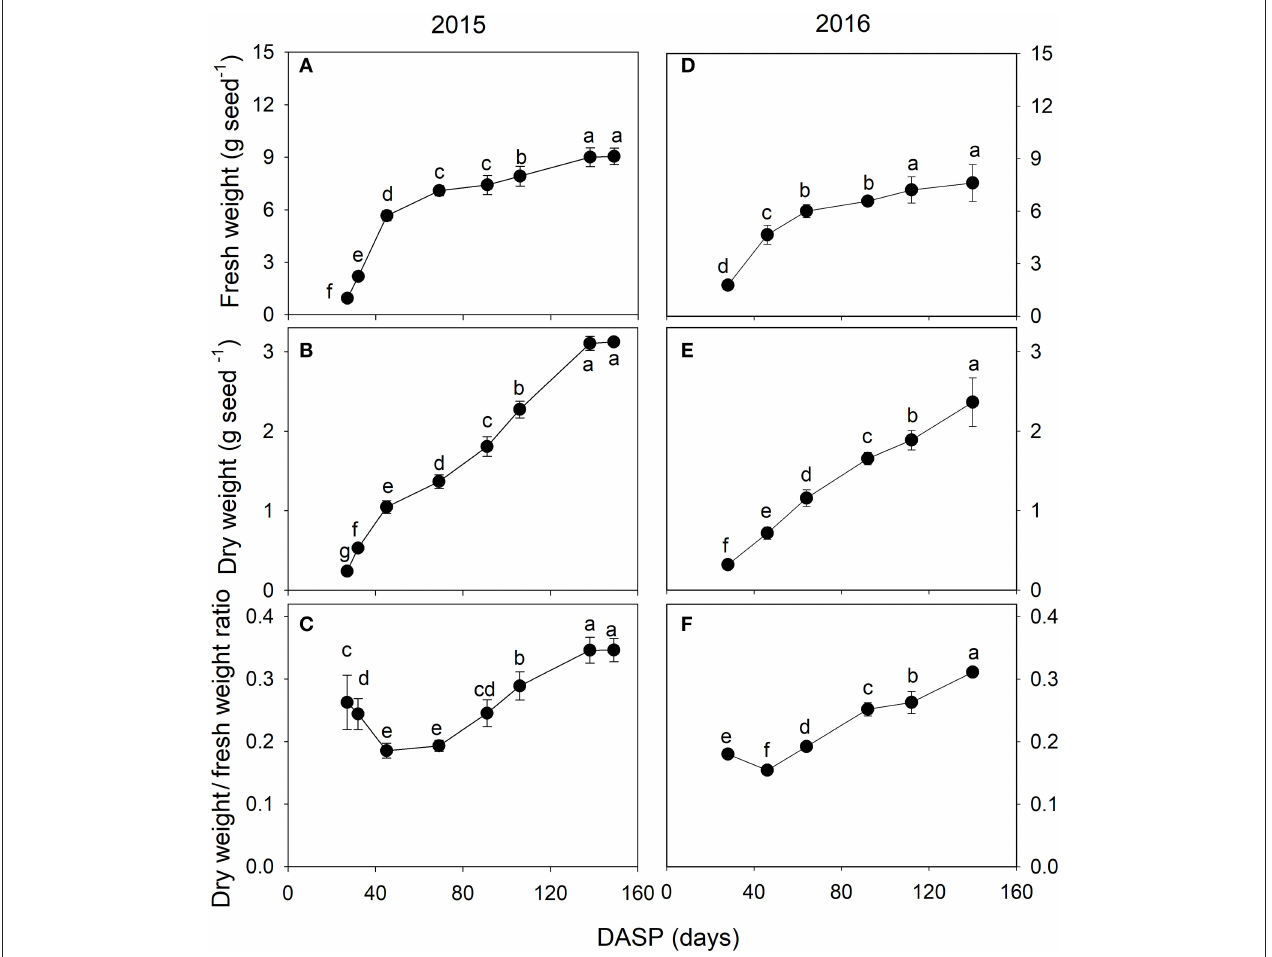
( Figure 8B ): In the seeds, the rate of gross photosynthesis P g was very high at the beginning of the seed development. After that it decreased rapidly. In the leaves, a contrasting pattern from low rates of P g at the beginning of the growing season to higher ones later was found. Accordingly, the rate of P g was at early stages much higher in seeds than in leaves, whereas later this was reversed ( Figure 8